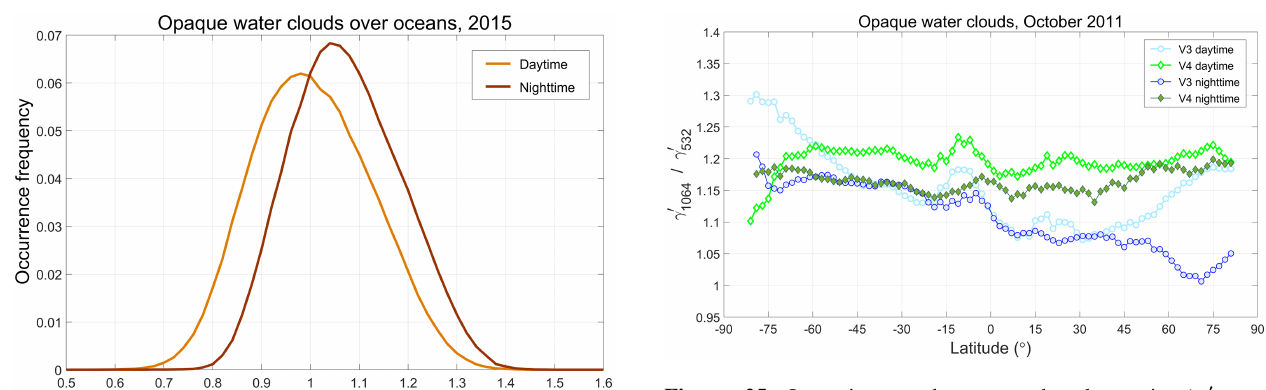
Figure 25. Layer-integrated attenuated color ratio ( χ (cid:48) γ (cid:48) /γ (cid:48) ) for opaque water clouds measured during Octo- 1064 532 ber 2011. V3 values are plotted using blue circles, while V4 values are shown by green